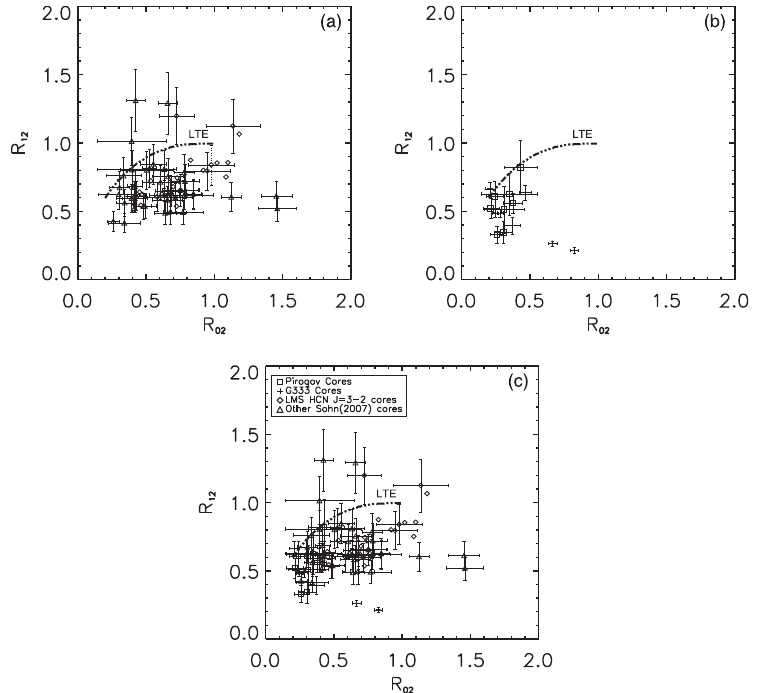
Fig. 4. HCN J = 1 ! 0 hyperfine ratios, R 12 plotted against R 02 , for (a) 64 low-mass starless sources located in the Taurus-Auriga and Ophiuchus molecular clouds and (b) 15 high-mass objects considered in this work, made up from seven high-mass protostellar cores located in G 333-6.02 and the eight sources in Fig. 1 of Pirogov (1999). In (c), both sets of objects are plotted together. LTE represents the line along which cores displaying HCN hyperfine spectral components obeying the Boltzmann equations of thermodynam- ical equilibrium would